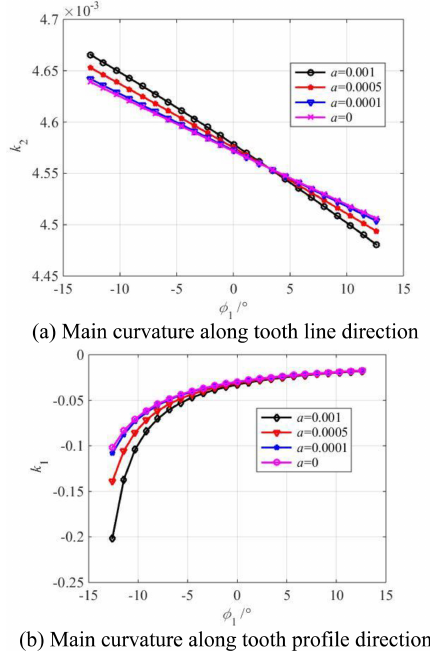
Figure 9. Influence of parabolic coefficient a on main curvature of the modified concave tooth